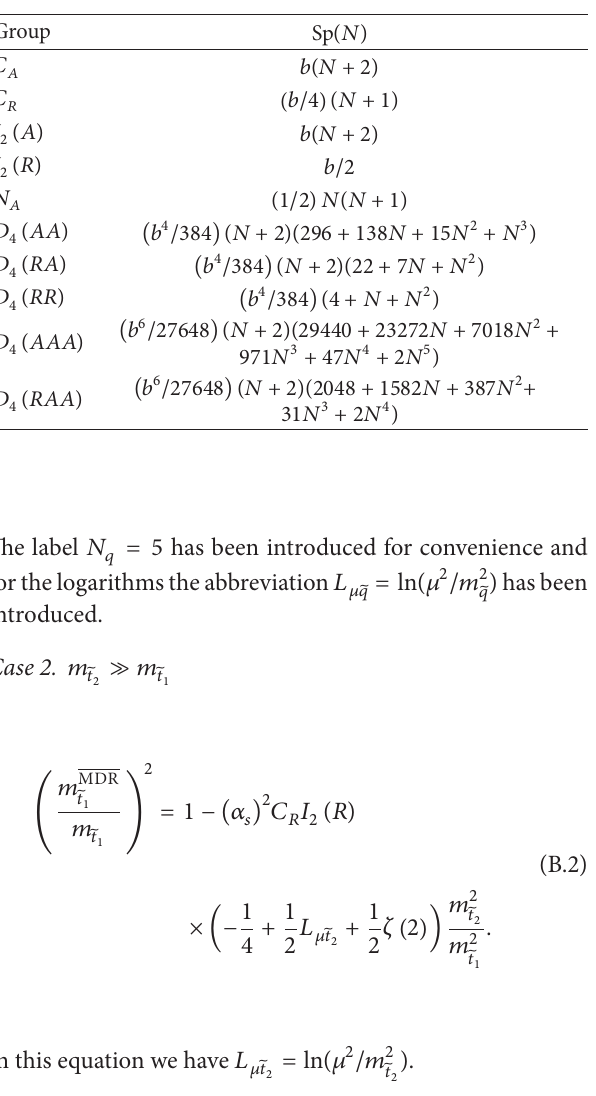
Table 4: Sp (𝑁) Group invariants (here 𝑅 is the fundamental